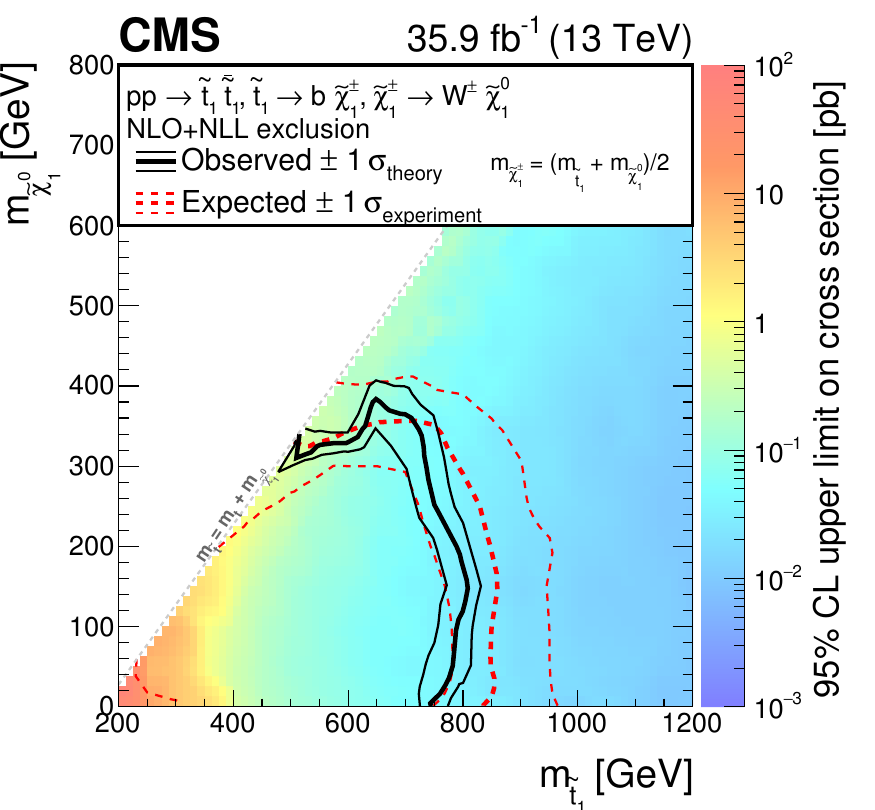
Figure 10 . Exclusion limits at 95% CL for top squark pair production followed by the decay ! bW t 1 ! b (cid:31) (cid:6) (cid:31) 0 (T2bW), in the mass plane m versus m . The areas to the left and below (cid:6) 1 1 e t 1 e (cid:31) 0 1 the solid black curves represent the observed exclusion and the (cid:6) 1 standard deviation contours e for the NLO+NLL cross section calculations and their uncertainties [65]. The dashed red curves e e represent the corresponding expectation at 95% CL and (cid:6) 1 standard deviation contours for the associated experimental uncertainties. In the lower left corner of the diagram, where (cid:1) m is close to the top quark mass, the sensitivity of the search is signi(cid:12)cantly reduced due to the fact that the t 1 decay products are soft and often escape e